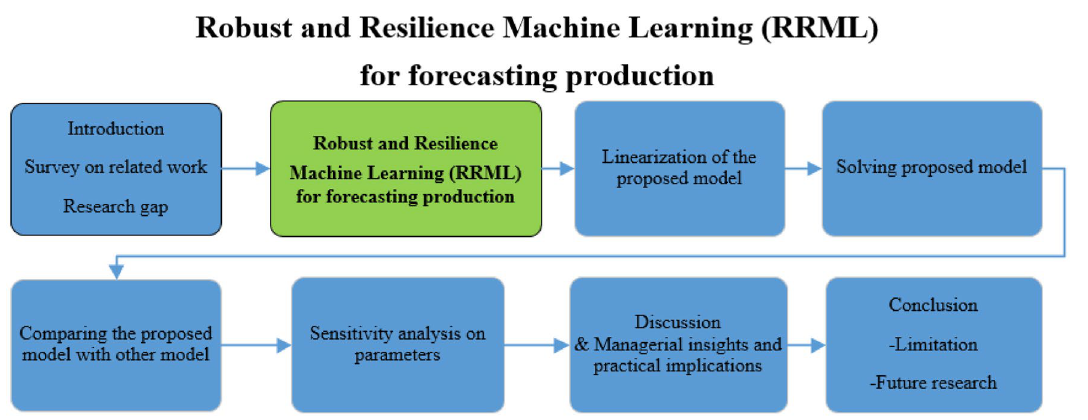
Figure 2. Research methodology.